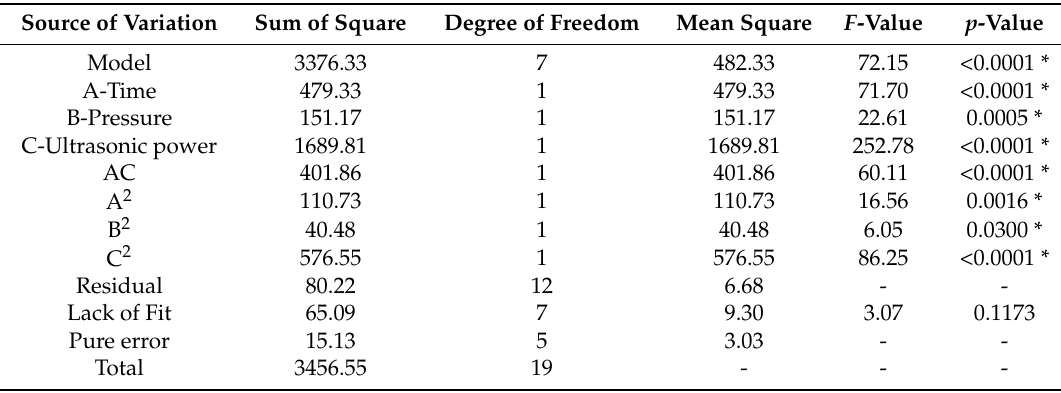
Table 6. The ANOVA results of pellet durability in a reduced